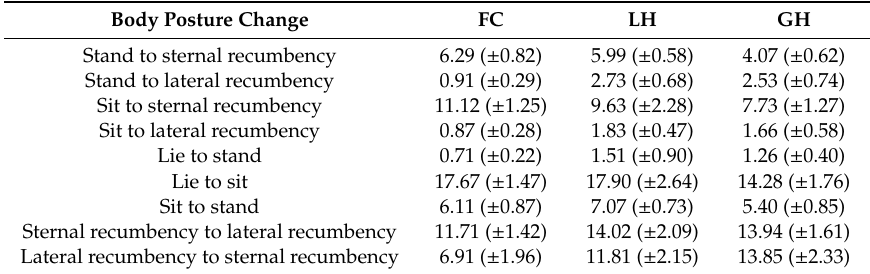
Table 4. Mean frequencies (per 24 h) and standard error of the mean (SEM) of body posture changes in the three tested farrowing systems: pens with farrowing crate (FC), single loose housing pen (LH), single loose housing pen of the group housing system (GH). No significant di ff erences were found among systems ( p > 0.05).